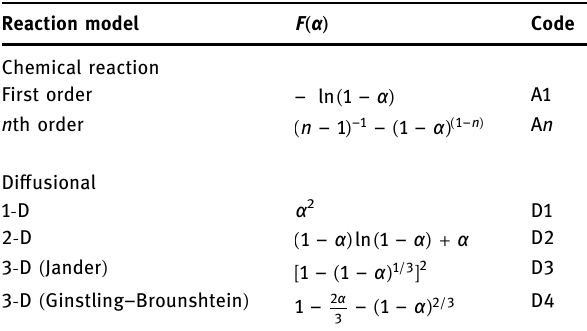
Table 5: The kinetic models used in solid state reactions Reaction